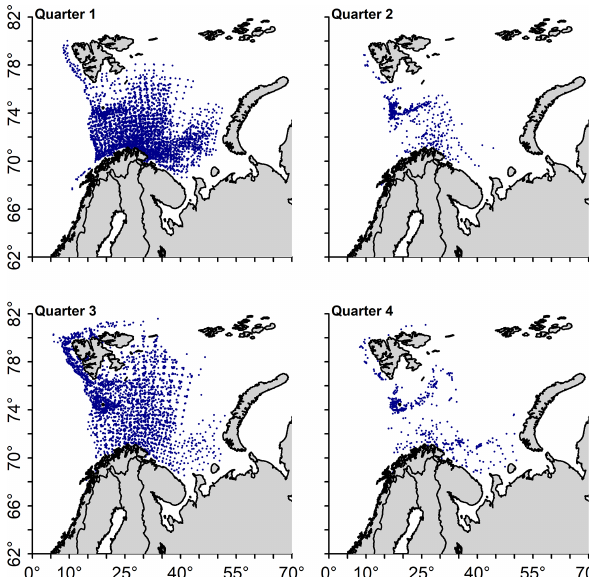
Figure 4. Sampling coverage in each quarter over all years com- bined. Each dot denotes a stomach